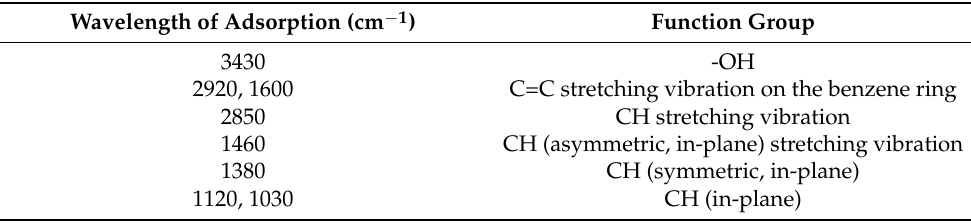
Table 3. Functional groups in the asphaltene analyzed from FT-IR spectra.